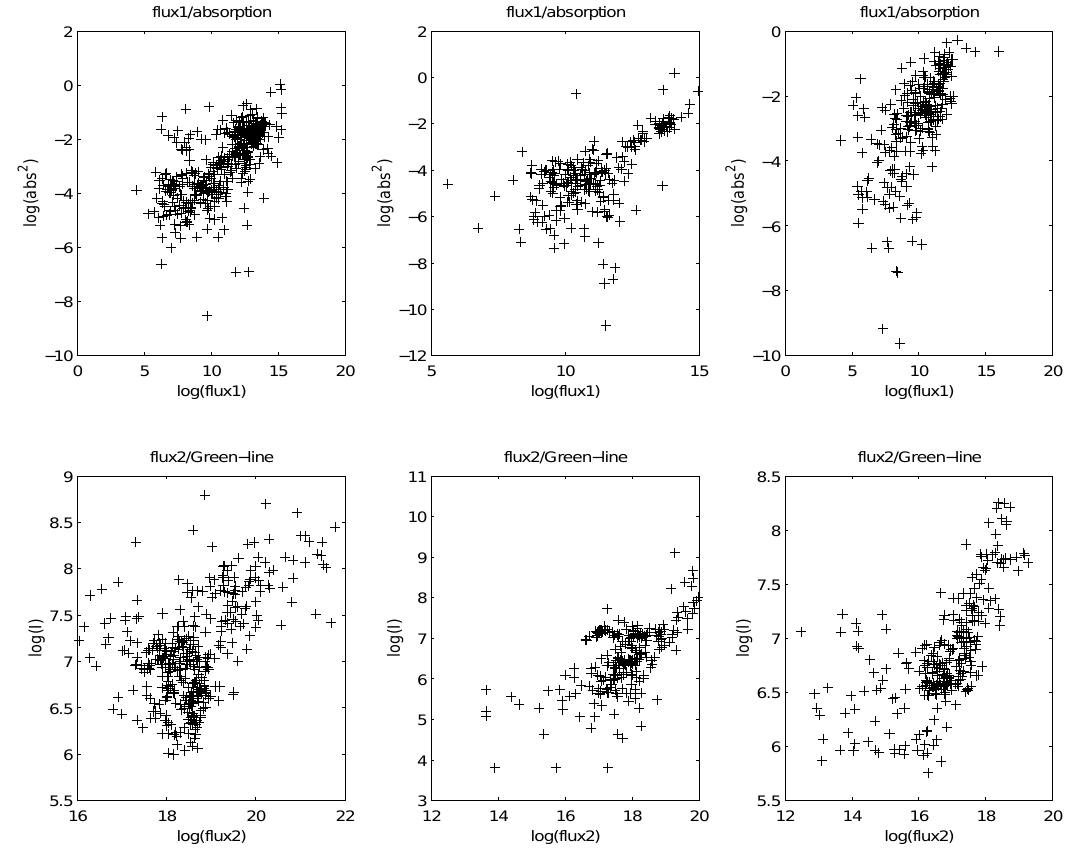
Fig. 3. Dispersion plots for the electron flux and absorption (upper panels) and the electron flux and green-light intensity (bottom panels) for the three data sets at Tromsø: (a) 13–14 Feb 1996, (b) 9 Nov 1998, and (c) 12 Feb 1999. The y -axis in the upper panels gives the logarithm of the squared absorption and the logarithm of the green-light intensity in the bottom panels. In all cases, the x -axis gives the logarithm of the flux at the corresponding height/energy